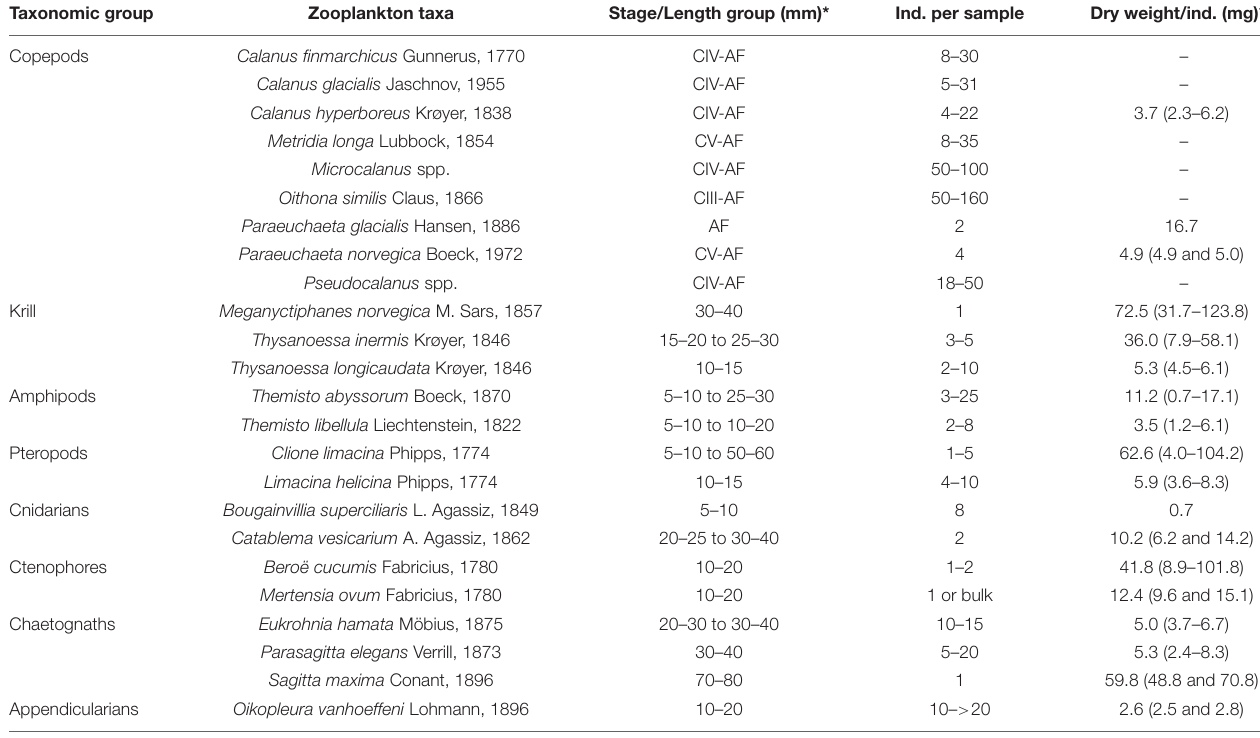
TABLE 1 | Overview of zooplankton taxa collected during Nansen Legacy cruise Q3 in August 2019 in the Barents